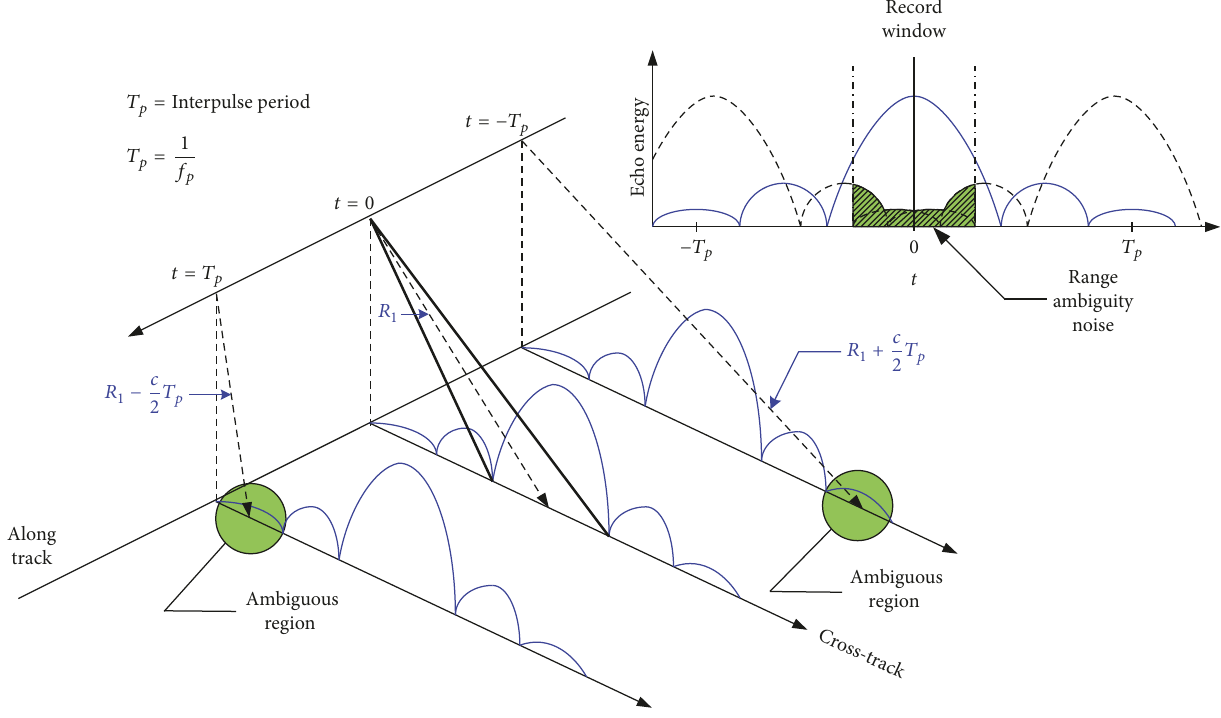
Figure 3: Concept diagram of range